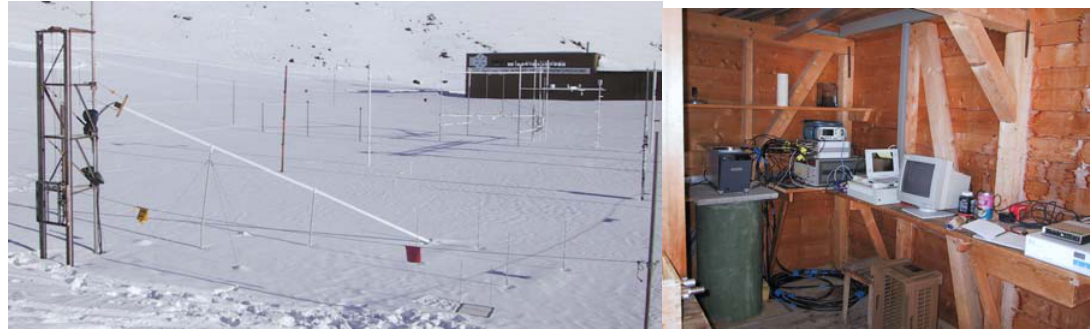
Figure 11. (left) High-elevation test site of ‘TAUPE-sensor’ at Weißfluhjoch, Davos, Switzerland. (right) Shelter with measurement devices.